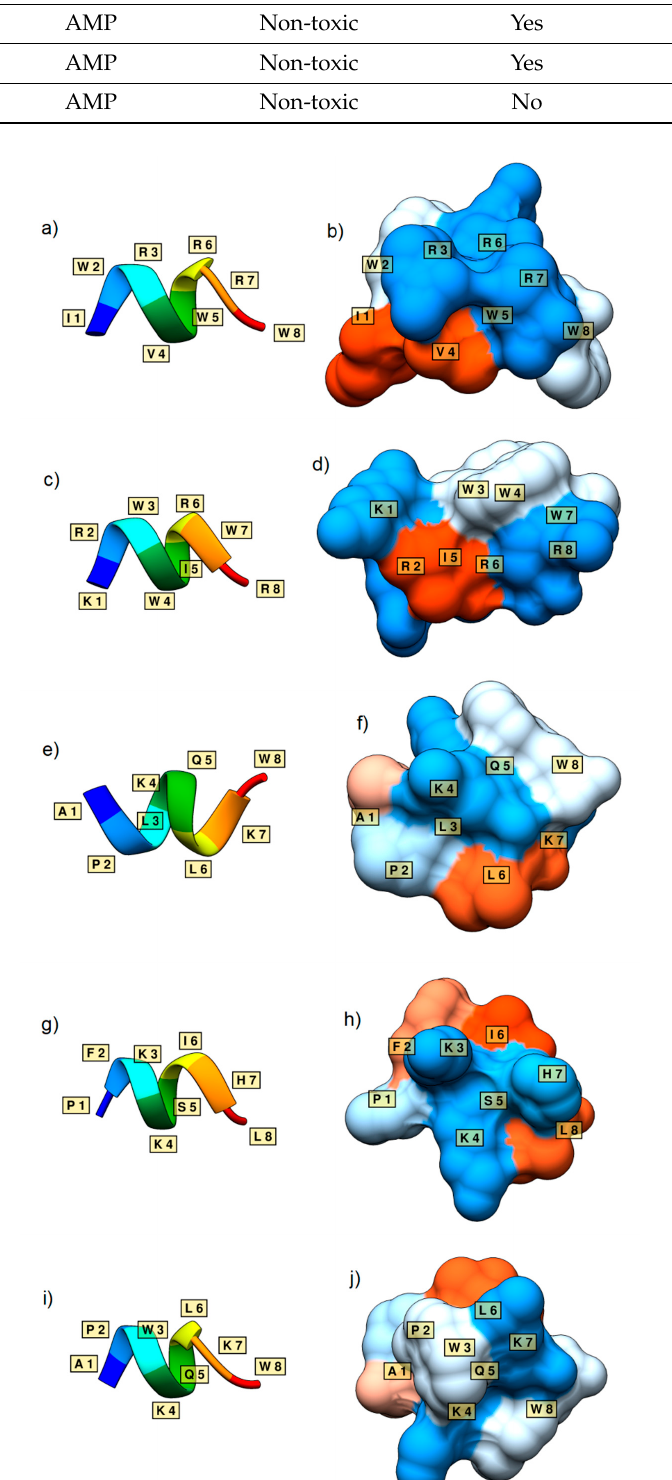
Figure 5. Secondary structures and surface representations of sequences IWRVWRRW ( a , b ), KRWWIRWR ( c , d ), APLKQLKW ( e , f ), PFKKSIHL ( g , h ), and APWKQLKW ( i , j ). The residues are labelled according to their one-letter abbreviation. Surface representations show the hydrophilicity (blue) and hydrophobicity (orange) of the peptides. White surfaces represent a hydrophobicity of around